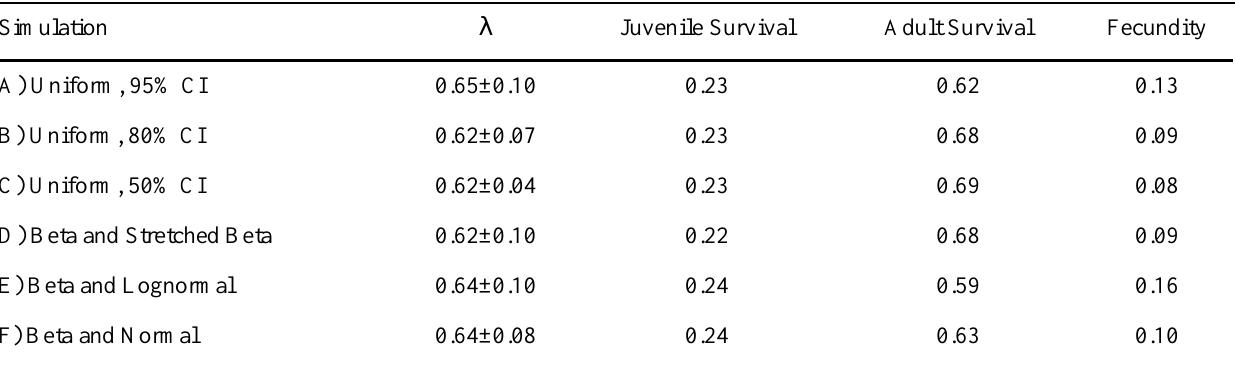
Simulation l Juvenile Survival Adult